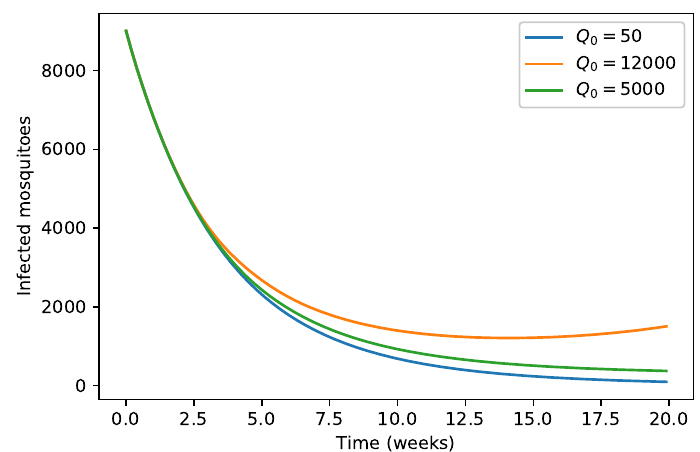
Figure 5. Variation of infected mosquitoes population with respect to Q 0 .